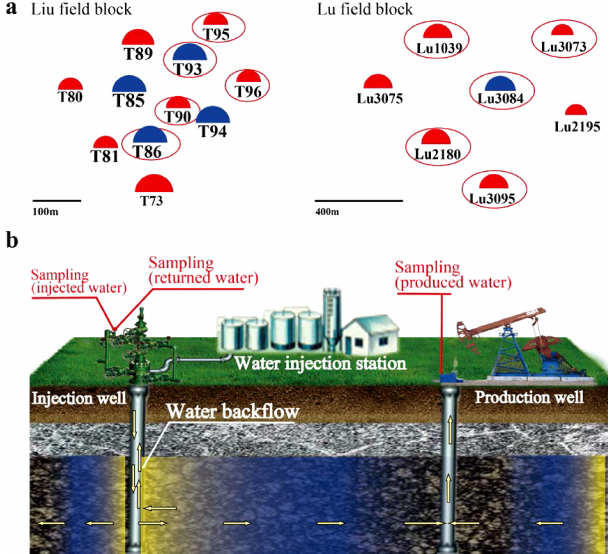
Figure 1. Schematic diagram showing (a) the distribution of the injection and production wells of the Liu and Lu field blocks, and (b) the wellhead and downhole of injection and production wells, and the location where the water samples were collected. The in- jected water samples were collected from the well head and the zone close to downhole (obtained by backflow, that is, the injected wa- ter flowed upward through the injection well) of the injection wells. The water samples in reservoir strata were collected from the well- head of production wells. T86, T93, and Lu3084 are the selected injection wells, and T90, T95, T96, Lu1039, Lu2180, Lu3073, and Lu3095 are the production